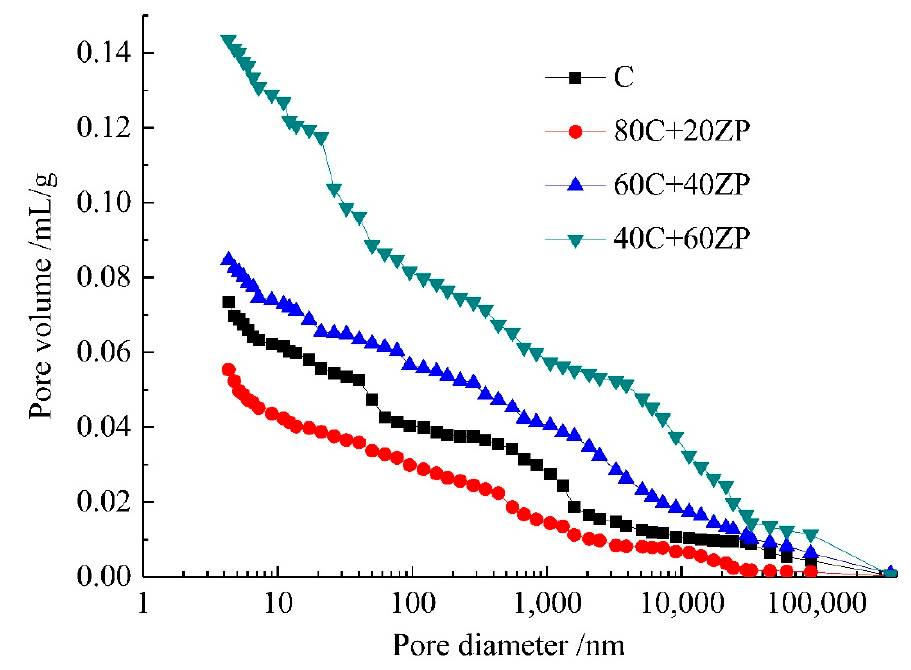
Figure 9. Pore size distribution curves of 90-day cured samples. Table 4. Pore structure parameters of the 90-day cured samples.